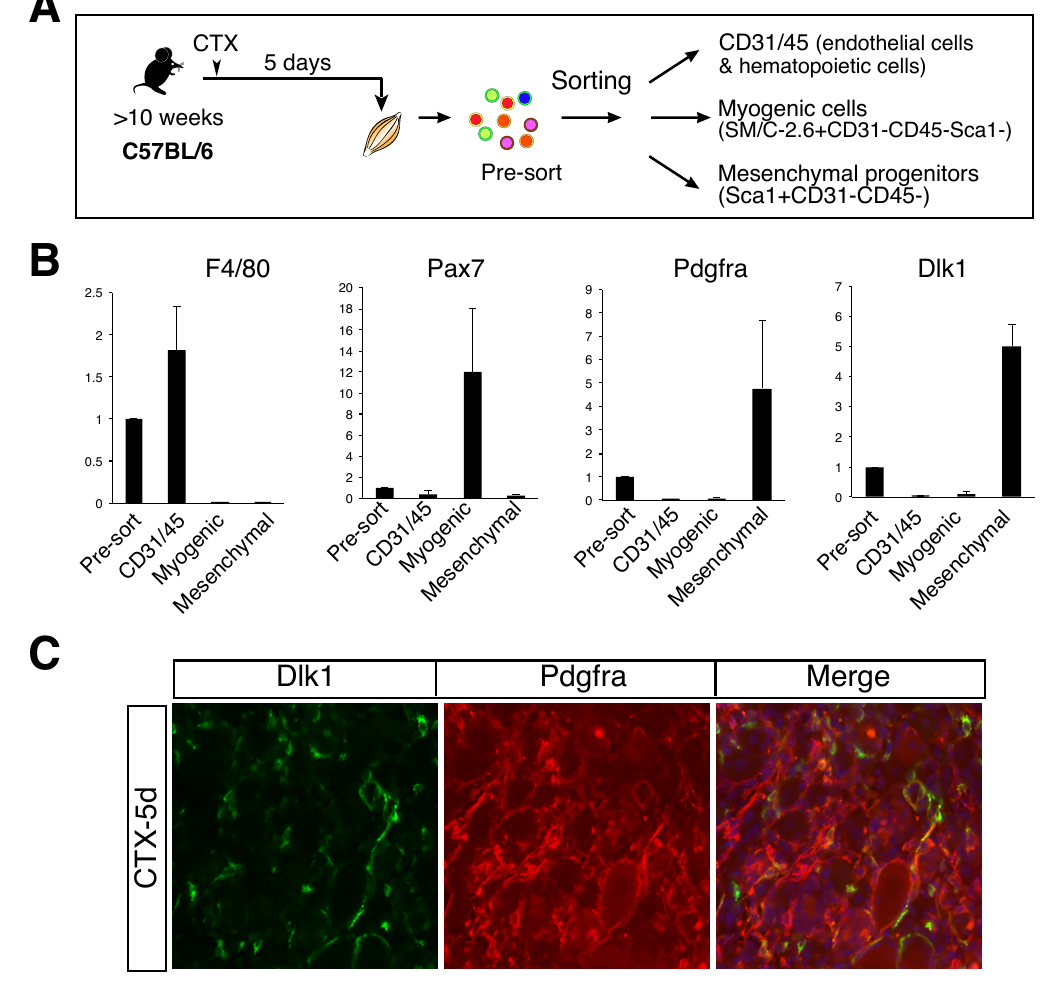
Figure 3. Specific expression of Dlk1 in mesenchymal progenitors. ( A ) Experimental scheme for analyses of Dlk1 in mononuclear cells from regenerating hindlimb muscle. ( B ) Relative mRNA expression levels of Dlk1, macrophage (F4 / 80), myogenic cells (Pax7), and mesenchymal progenitor marker (Pdgfra) in each cell fraction. Data show the average of three independent sorting experiment with SD. Three mice were used in this study. ( C ) Immunostaining of Dlk1 (green), Pdgfr α (red), and DAPI (blue) in the regenerating TA muscle of C57BL / 6 five days after CTX injection. Scale bar: 50 µ